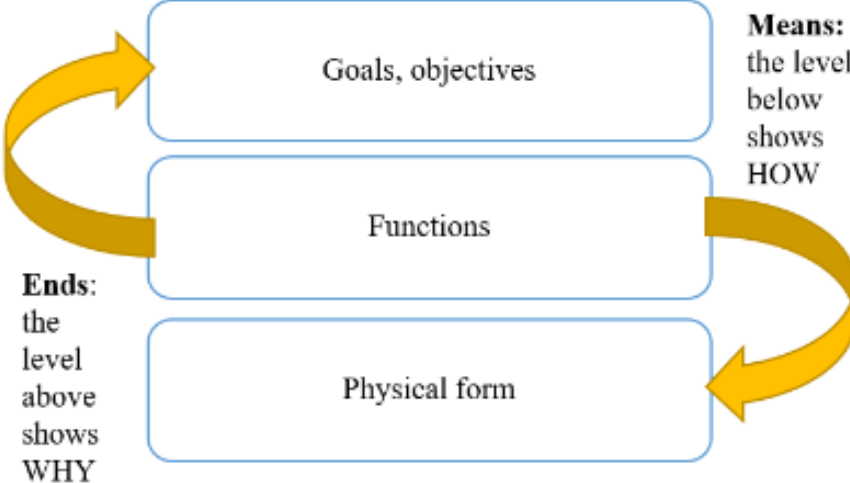
Figure 2. How the means-ends structure of an abstraction hierarchy can support the investigation of interactions in a work